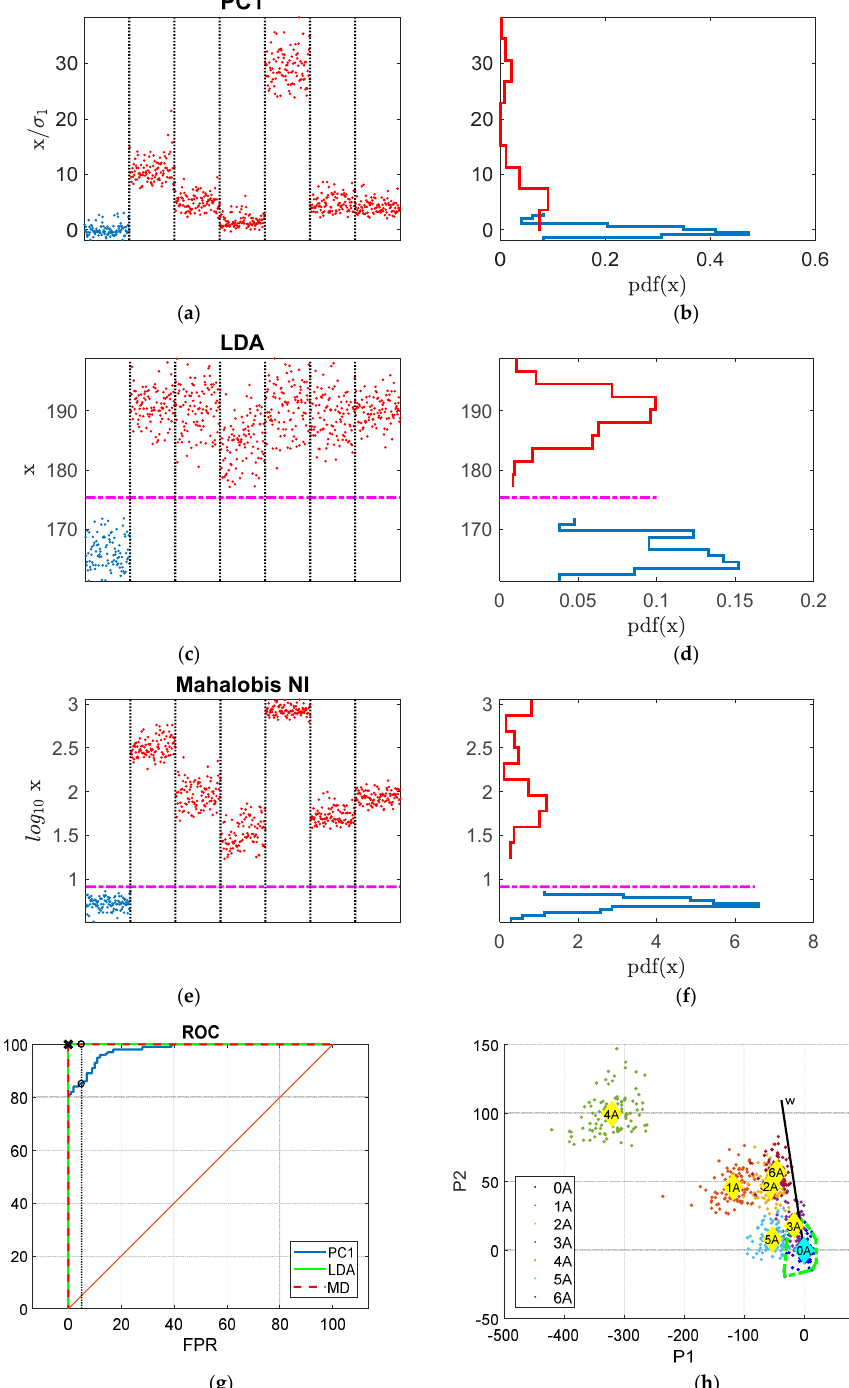
Figure 14. Results for for condition 12 ( 280 Hz,1800 N ) alone : ( a , c , e ) the 3 different dimensionality reductions; ( b , d , f ) the corresponding empirical pdf for the healthy condition (blue) and for the 6 damage conditions (red). The x axis represents the 100 observations for each of the different damage conditions (ordered from 0A to 6A) which are separated by the black dotted lines. ( g ) ROC curves for the three 1-D reductions. The 5% significance threshold values are highlighted with the black circles; the black x denotes the position of the novelty index (NI) threshold computed according to the MC repetition introduced in Section 2.4.1—in magenta in ( h ) The 2-D PCA visualization of the dataset (condition 12) and the LDA direction w